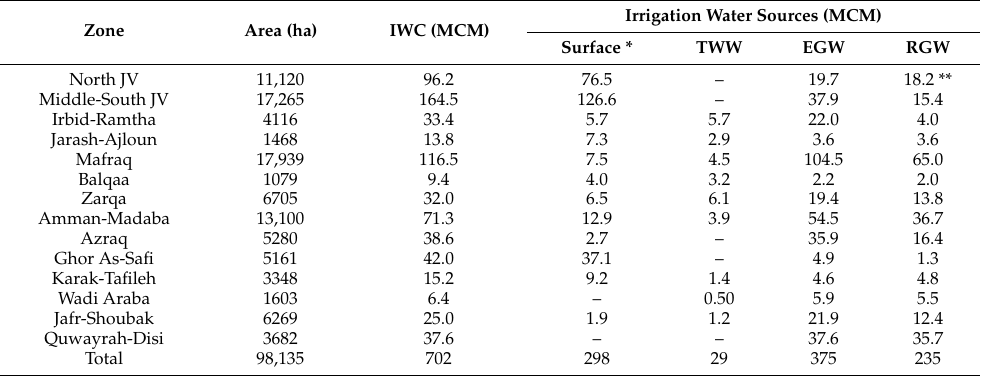
Table 4. Irrigated area, IWC, estimated (EGW), and recorded (RGW) groundwater abstraction for the different irrigated zones during 2019.